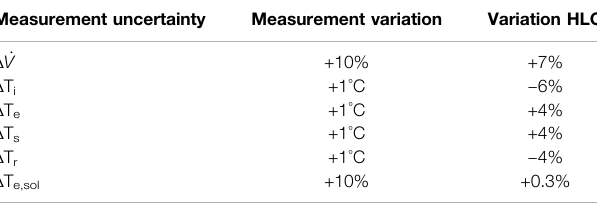
TABLE 5 | Sensitivity of the HLC to measurement